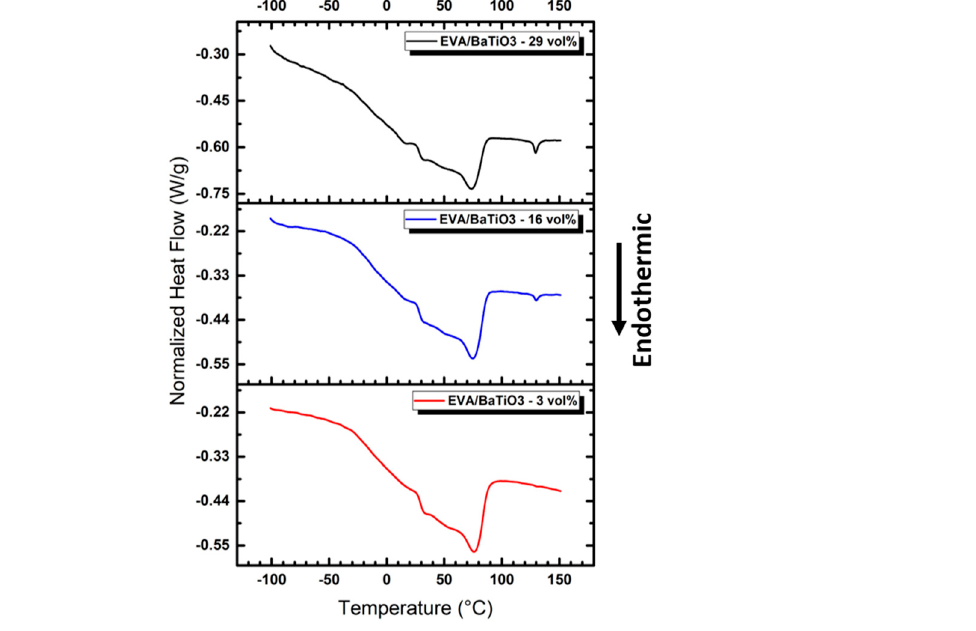
Figure 3. DSC analysis of EVA-BaTiO 3 unstructured composites: 3 vol%, 16 vol% and 29 vol%. Table 1. Glass transition, melting temperatures and enthalpy of melting as a function of the particle ratios.